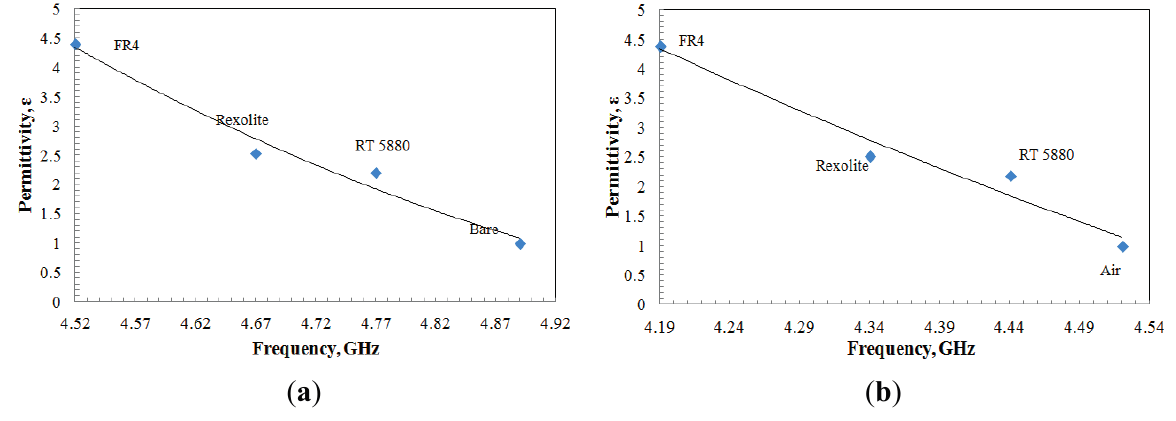
Figure 11. Sample permittivity, ε multi-ring; ( b ) centered-gap sensor.